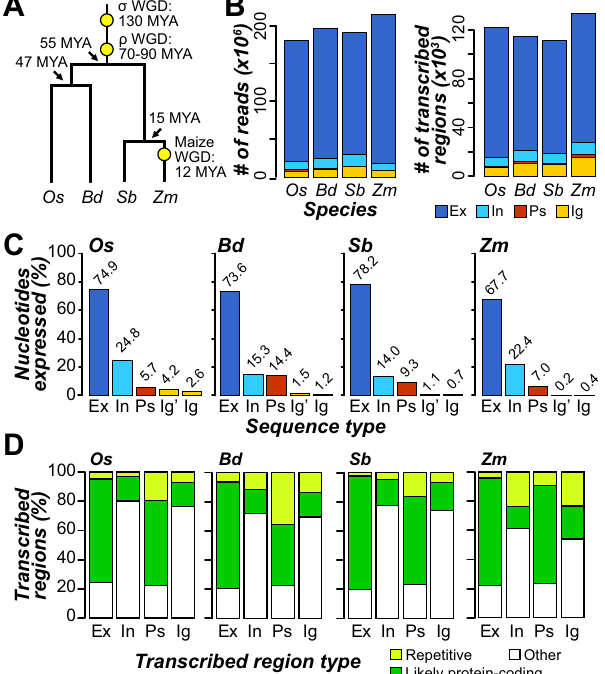
Figure 1. Phylogenetic relationships between and transcriptome content in the four Poaceae species 28–30 . (A) Phylogenetic relationships between rice ( Os ), B. distachyon ( Bd ), sorghum ( Sb ), and maize ( Zm ). Whole genome duplication (WGD) events are marked with yellow circles. MYA: millions of years ago. (B) Number of reads mapping to (left panel) and transcribed regions overlapping (right panel) exons (Ex; dark blue), introns (In; cyan), pseudogenes (Ps; red), and intergenic regions (Ig; orange). (C) Percent of nucleotides overlapped with transcribed regions that are annotated as exons, introns, pseudogenes, and intergenic regions. Abbreviations are the same as in (A) . Ig’ represents the proportion of intergenic space covered by transcribed regions that also overlap genic or pseudogenic regions. (D) Percent of transcribed regions that were classified as highly repetitive (lime), likely protein-coding (green), or neither of these two (Other;